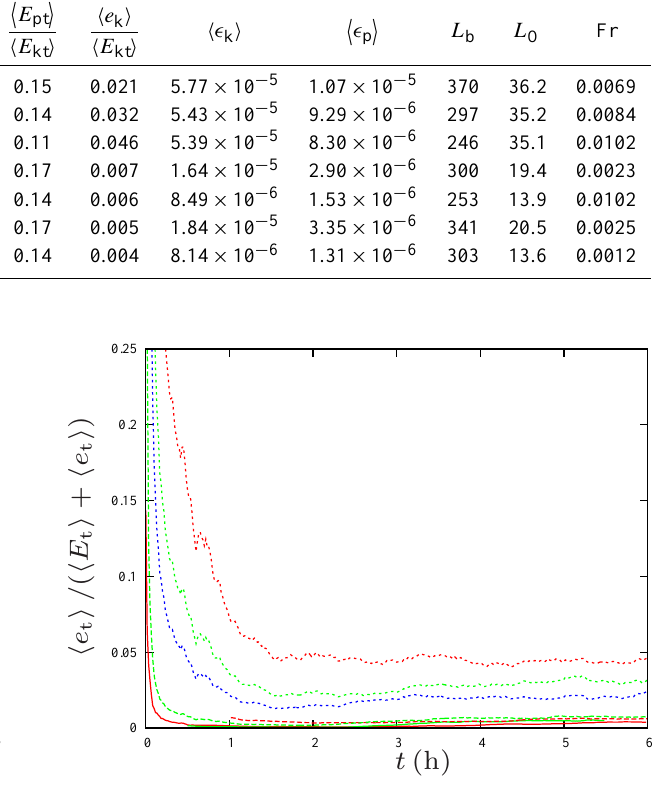
Figure 2. Temporal evolution of resolved h E kt i (upper curves) and (cid:10) E (cid:11) (lower curves) for the weak forcing case (red lines), moderate pt forcing case (green lines), and strong forcing case (blue line). Solid lines: 1 = 2m; dashed lines: 1 = 4m; dotted lines: 1 = 10m.